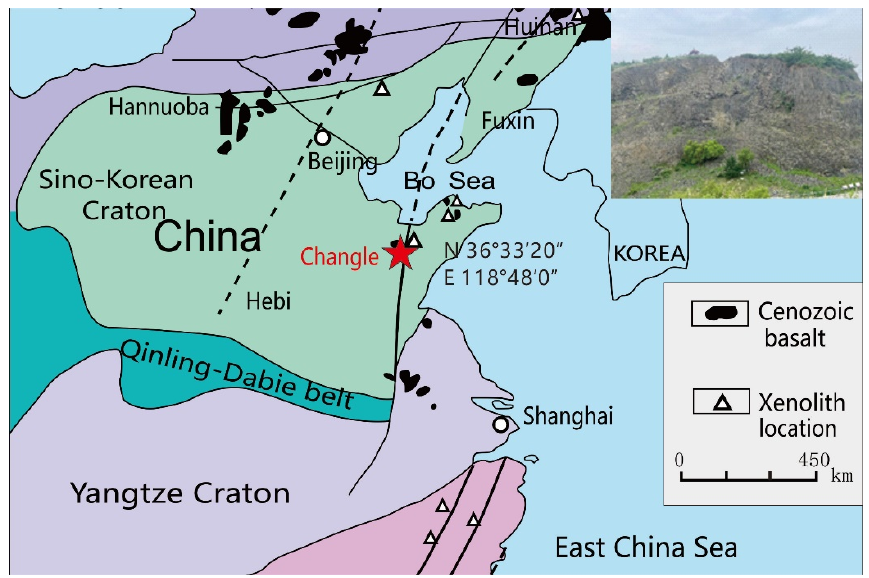
Figure 1. Geological sketch map of the eastern-China basalt area and its adjacent regions. Red star represents the area where the megacrysts were collected, i.e., Changle county, Shandong, China. Inserted photo on the right top shows the basalt exposures near the crater in this area.